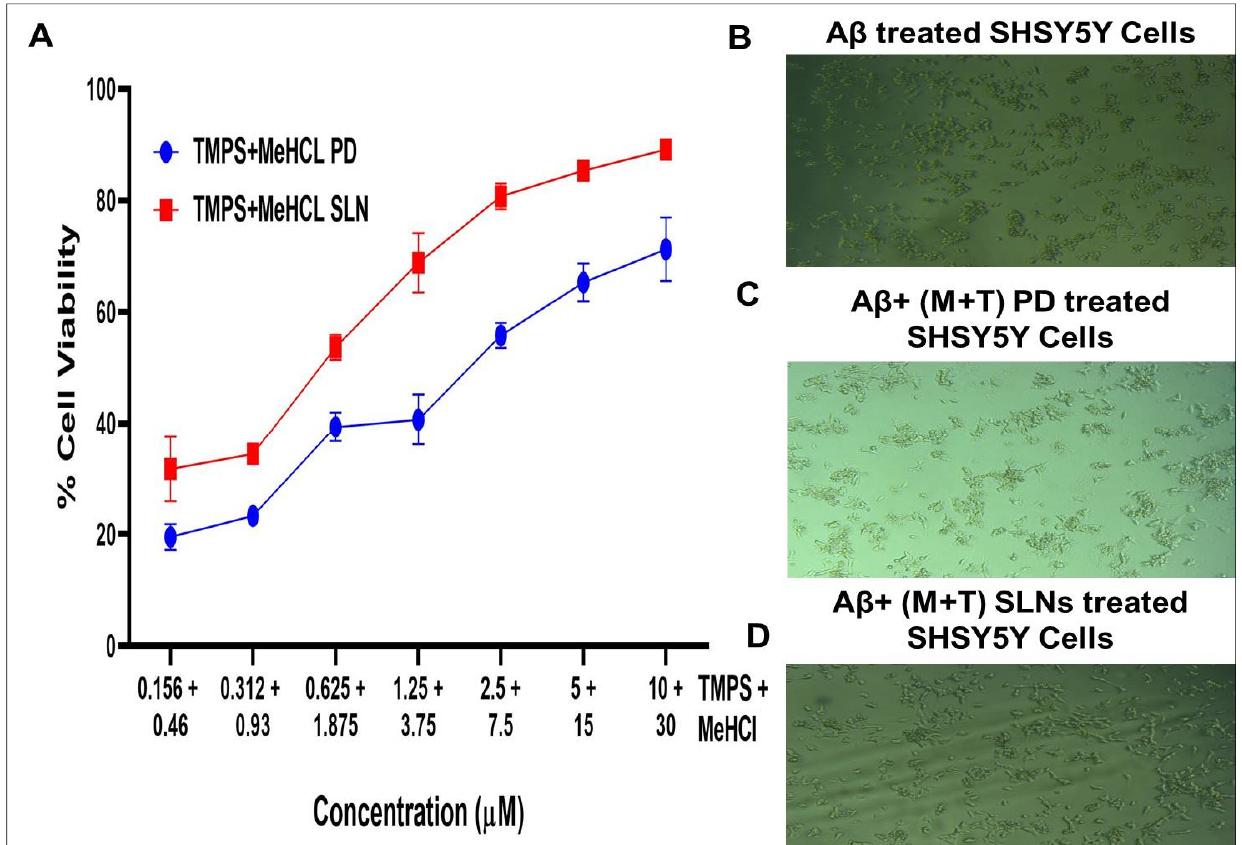
Figure 5. ( A ) The dose dependent activity of MeHCl & TMPS combination on SHSY5Y cells, ( B ) A β treated SHSY5Y cells, ( C ) A β + (M+T) PD treated SHSY5Y cells and ( D ) A β + (M+T) SLNs treated SHSY5Y cells. Data is represented in mean ± SD ( n = 3).